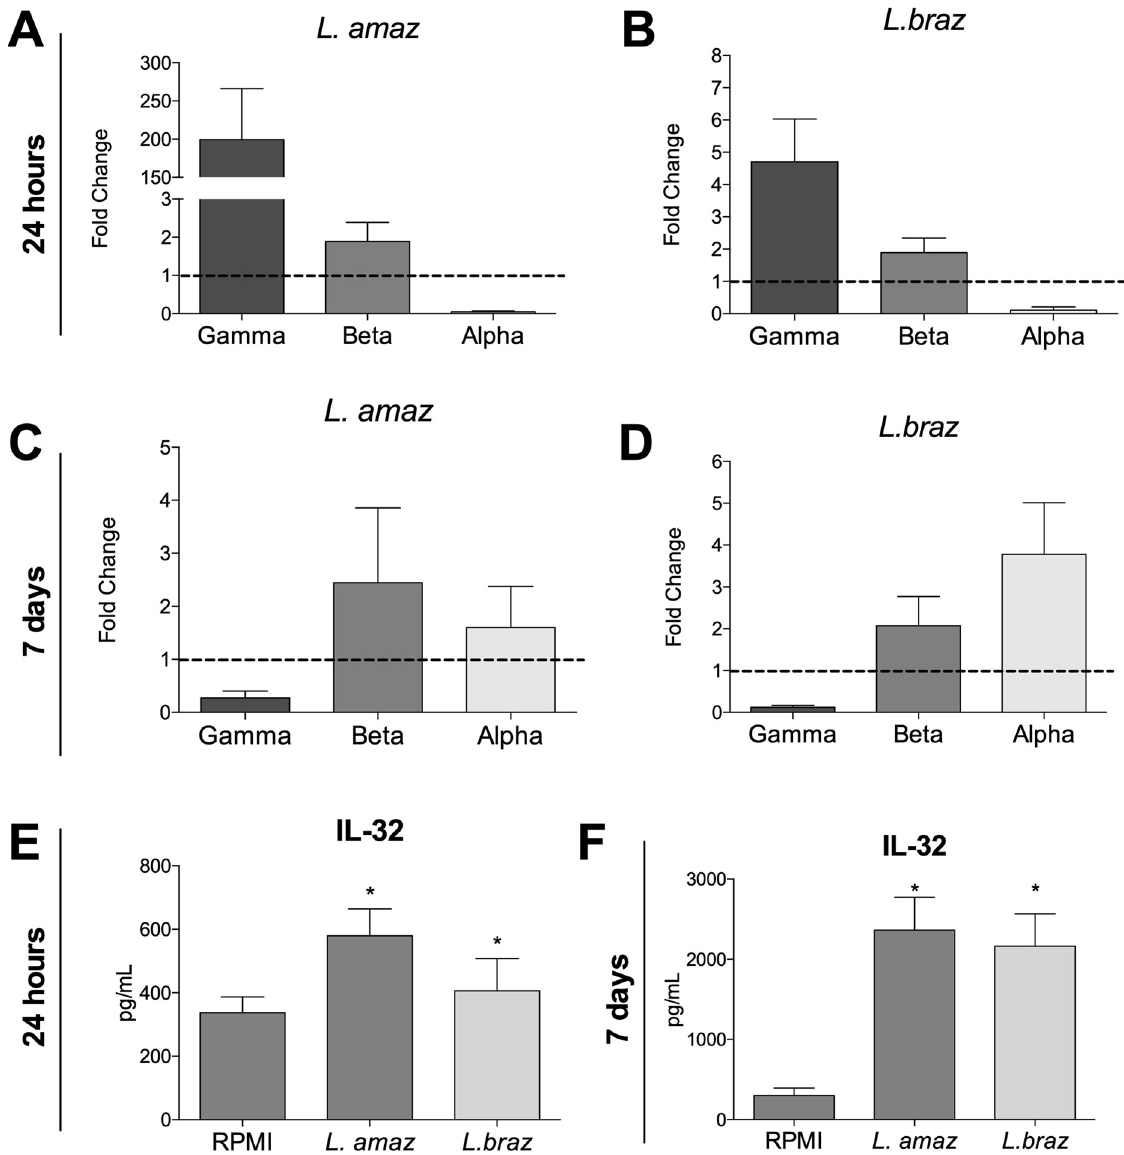
Fig 1. IL-32 isoform gene expression as well as intracellular IL-32 protein were measured in PBMCs stimulated with lysates (50 μ g/ mL) of L . amazonenis and L . braziliensis for (A-B-E) 24 hours and (C-D-F) 7 days. The data shown are the mean ± SEM of fold change in IL32 expression induced by Leishmania spp. compared to RPMI control (dotted line). Results are compiled from at least two independent experiments. The data shown are the mean ± SEM, n = 6. � p < 0.05 (RPMI vs Leishmania spp., Wilcoxon test).